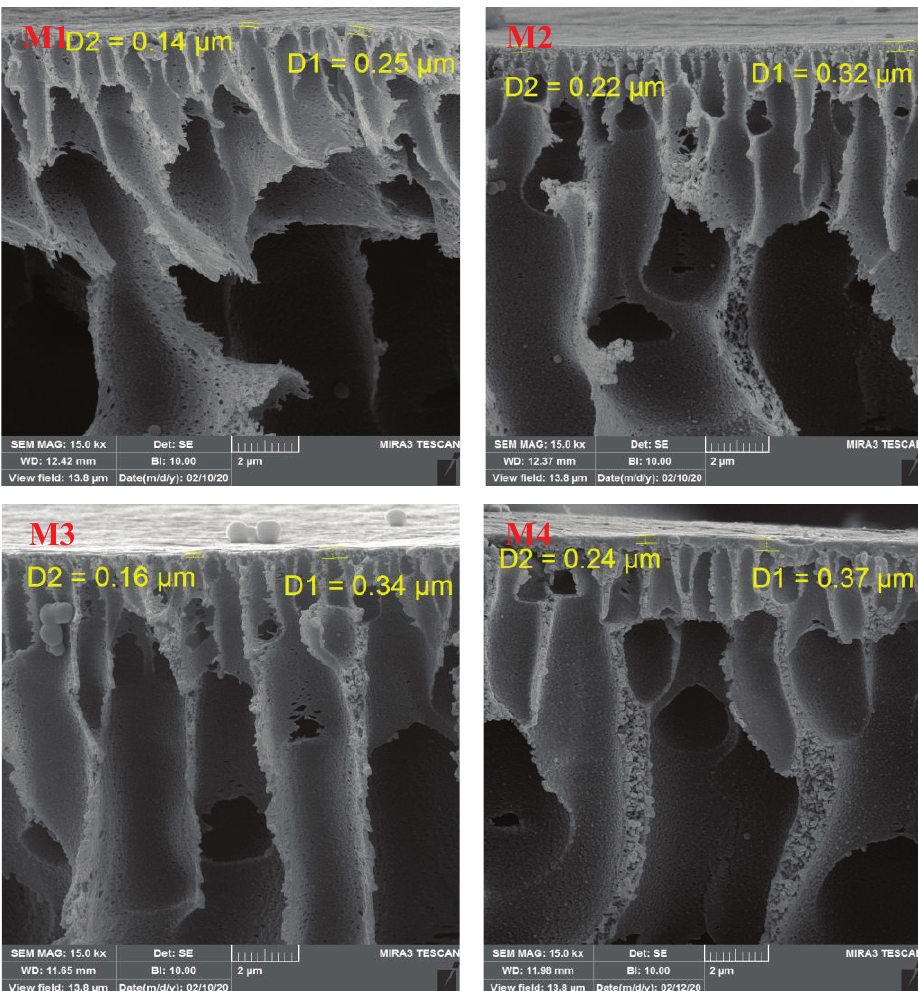
O membranes (M1-M4). 2 4